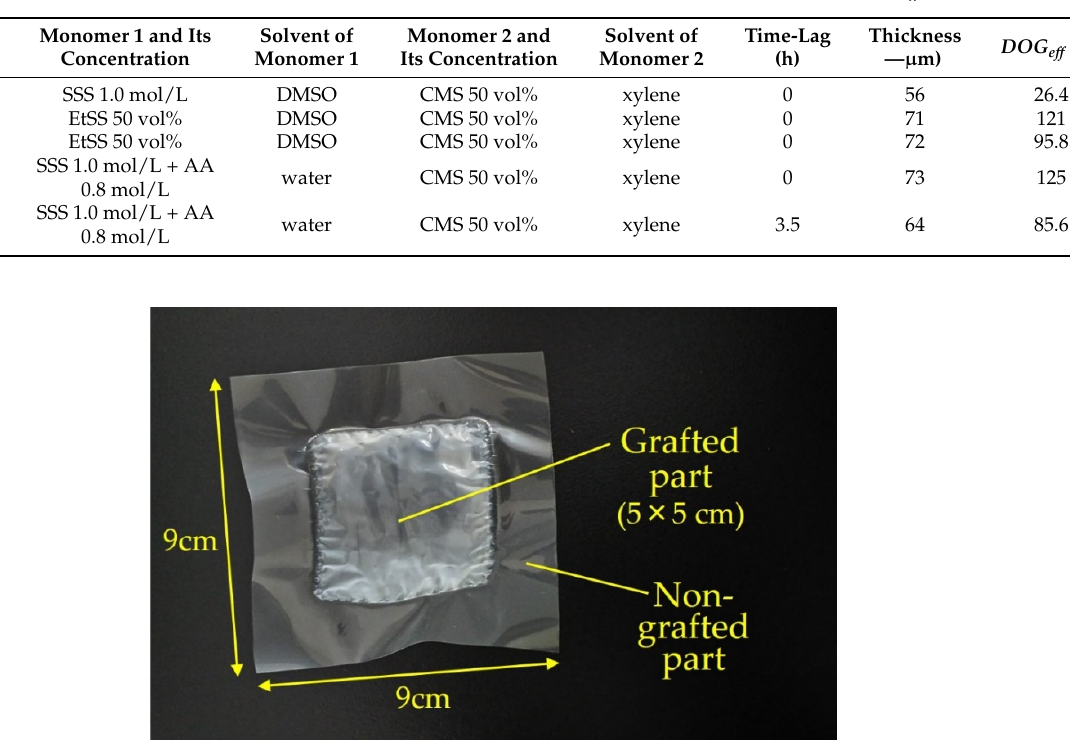
Table 4. Experimental conditions of RIAGP and obtained effective degree of grafting ( DOG eff ) .